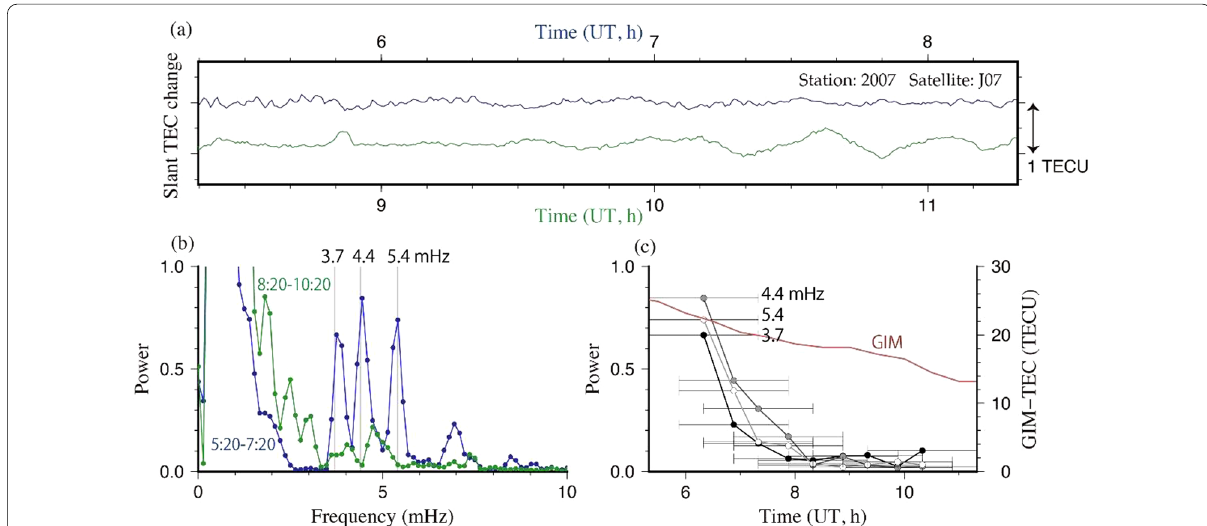
Fig. 6 a High-pass filtered slant TEC time series 5:20–8:20 (blue) and 8:20–11:20 (green) UT, at the 2007 station observed using J07 satellite. b Frequency components of the 2-h data 5:20–7:20 UT and 8:20–10:20 UT indicate that the peak powers mostly decayed in the second time window. c We select the three strong peaks (3.7, 4.4, and 5.4 mHz) and compare their powers obtained from a 2-h time window moving with a 1-h time step (horizontal bars indicate the periods representing the frequency spectra). The red curve in c indicates gentle afternoon decrease of vertical TEC above the volcano from GIM